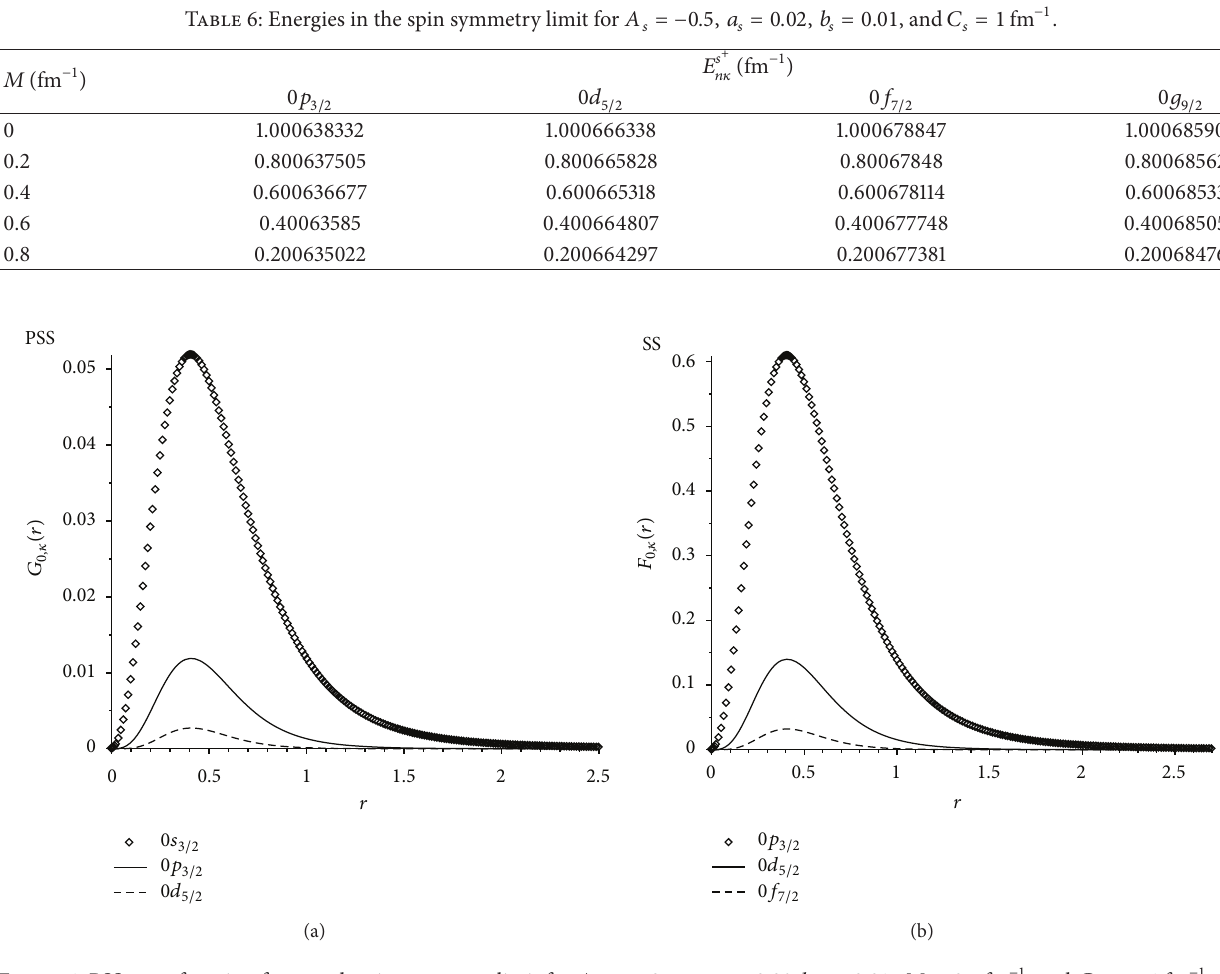
Figure 1: PSS: wavefunction for pseudospin symmetry limit for 𝐴 wavefunction for spin symmetry limit for 𝐴 𝑠 = −0.5 , 𝑎 𝑠 = 0.02 , 𝑏 𝑠 = 0.01 , 𝑀 = 0.5 fm −1 , and 𝐶 𝑠 = 1 fm −1